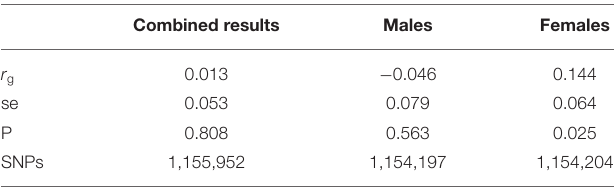
TABLE 2 | Genetic correlation results between endometriosis and melanoma for the combined data and separate analyses for males and females.